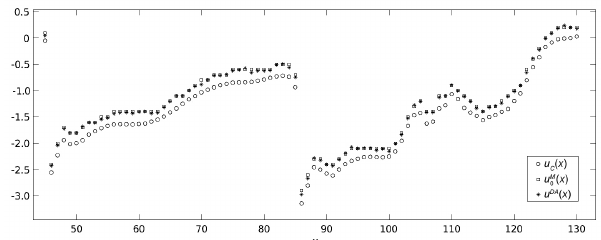
Fig. 15 Results comparison with a control variable u C for nobs = 6.